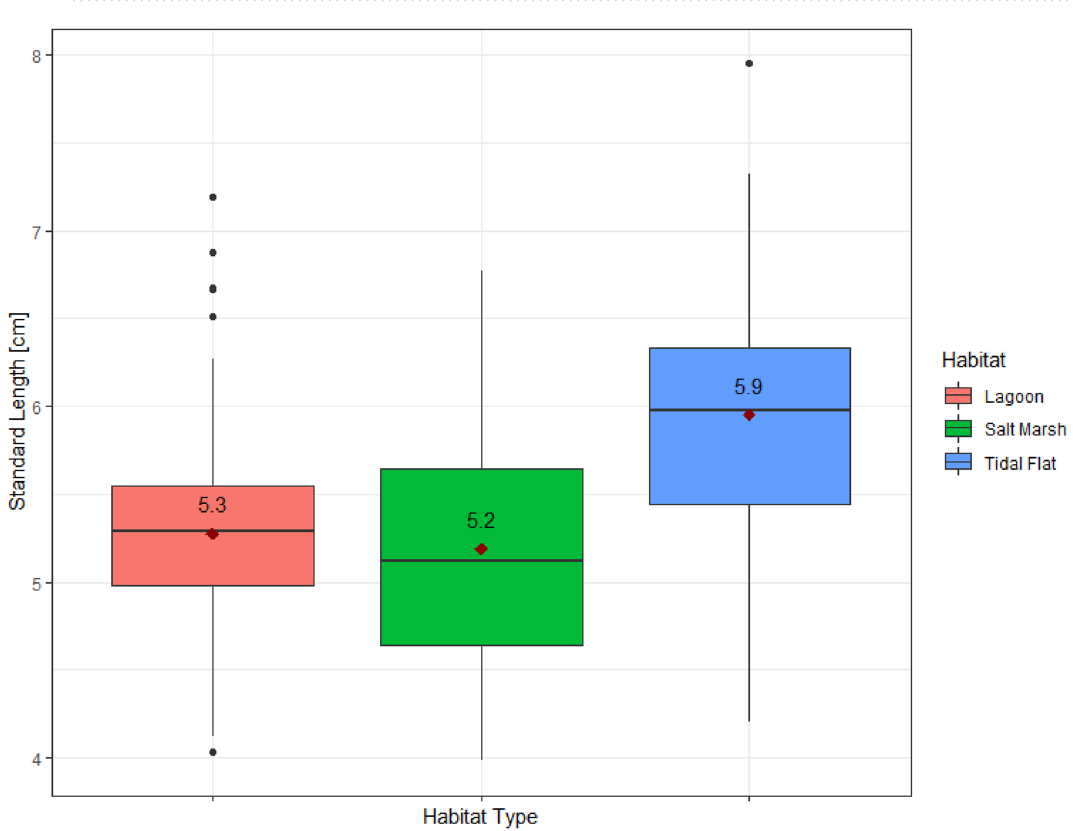
Figure 5. The variation of body size, represented by standard length (cm), observed in each habitat type. The solid black lines represent the median of each habitat. The red triangles represent the average standard length (with the average value in black above each